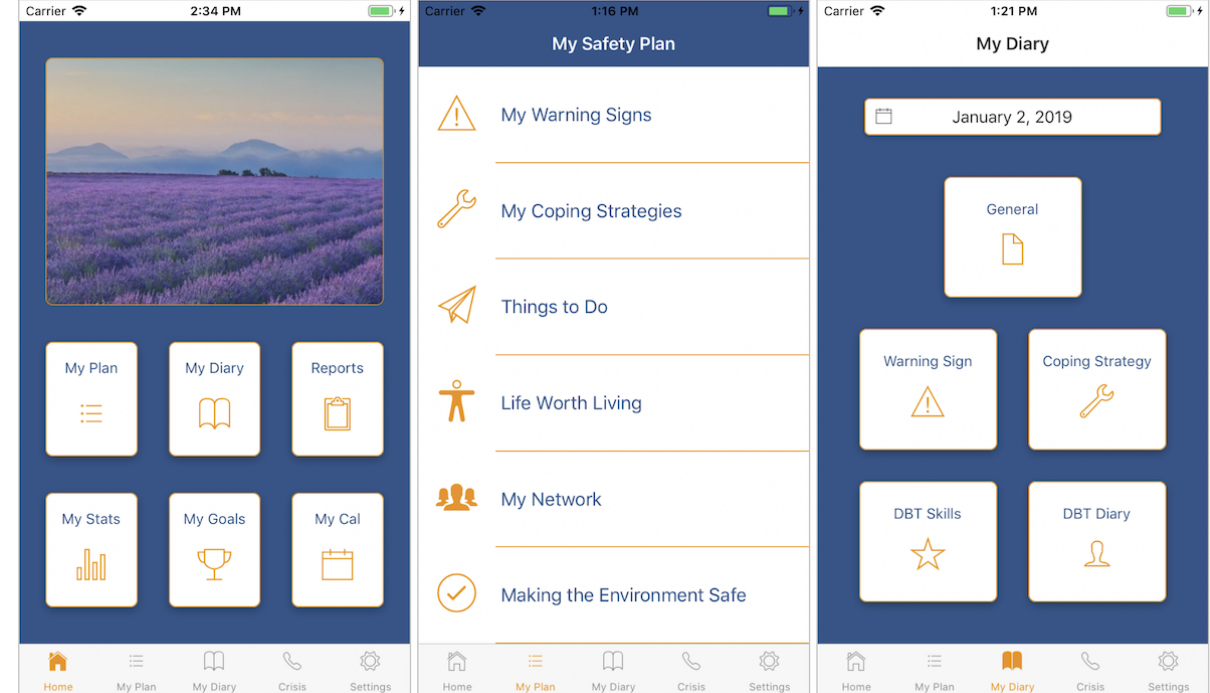
Figure 2. Screenshots from Home, Plan and Diary tabs within the SafePlan app.